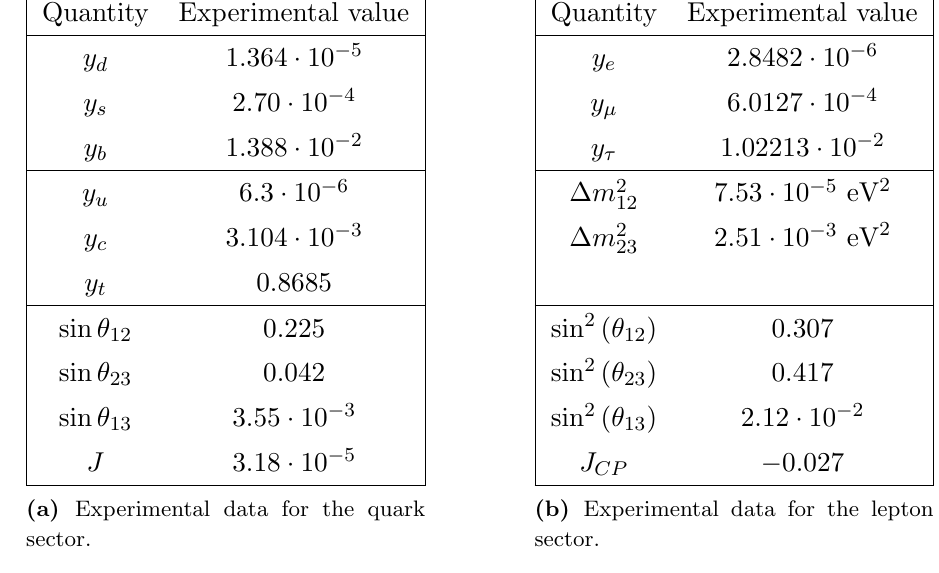
Table 7. Experimental values for the masses and mixings [29, 32]. Yukawa couplings are evaluated at 1 TeV. Experimental uncertainties are omitted as they are negligible compared with the widths of the theoretical